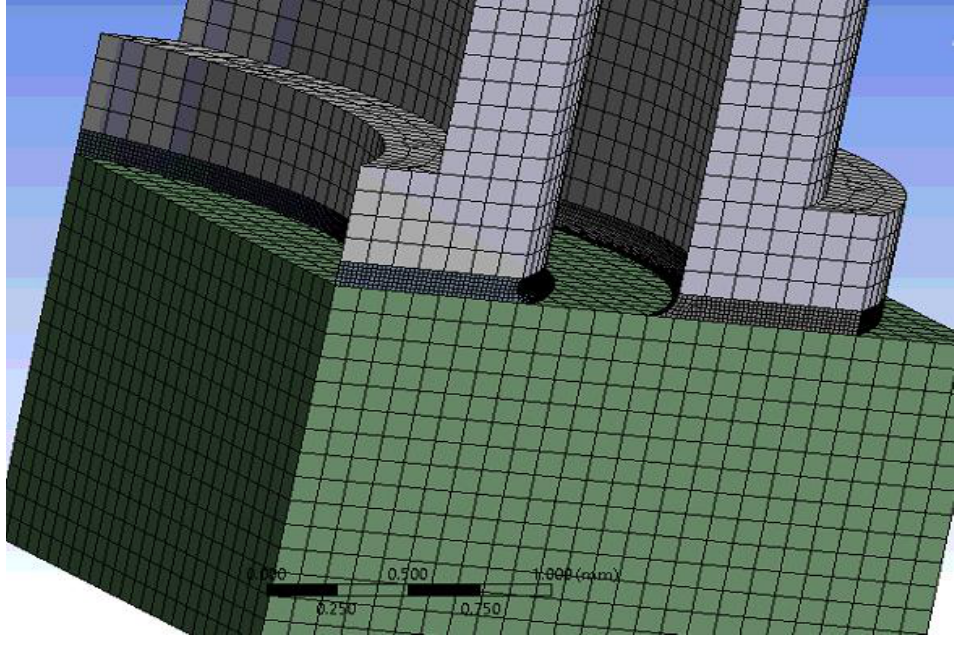
Figure 5. Mesh used for fin and braze.